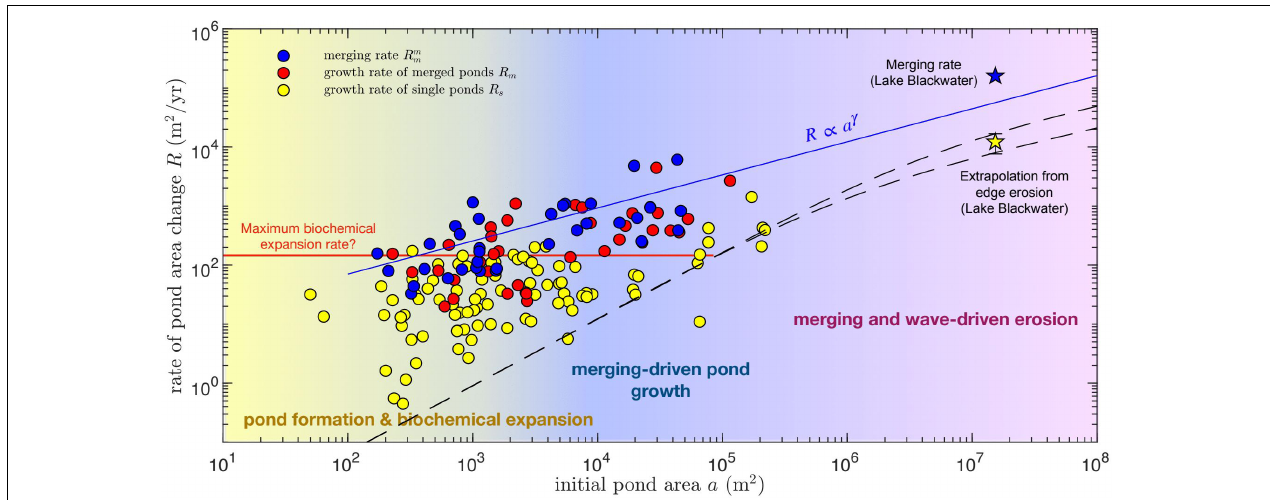
FIGURE 6 | Pond area growth rate R as function of initial pond area a, for single (yellow circles) and merging ponds (blue and red circles). The initial pond area for the growth rate of merged ponds is defined by the combined area of all merging ponds, whereas it corresponds to the size of the largest merging pond for merging rates. Dashed lines correspond to predictions of wave-driven marsh edge erosion rates G (see Figure 5 ) extrapolated to area rates assuming circular ponds: √ π a (cid:1) . Stars represent two measures of the area growth rate of Lake Blackwater, the rate of area change itself (defined as the area difference divided by the R = G (cid:0) 2 time period and denoted as a merging rate because it involves merging with neighboring ponds) and an extrapolation from the measured edge erosion rate G √ π a (cid:1) . Pond growth seems to be dominated by biochemical expansion, with a minor contribution from ( Figure 5 ), assuming a circular lake of area a: R = G (cid:0) 2 merging, at relatively small pond areas, and by pond merging for intermediate and large pond areas. Wave-driven erosion seems to play a minor role in pond growth even at the scale of Lake Blackwater. Merging growth rates (blue circles) can be fitted by a power-law relation (solid blue line). Single pond growth has a maximum rate of about 150 m 2 yr − 1 that changes little with pond area (solid red